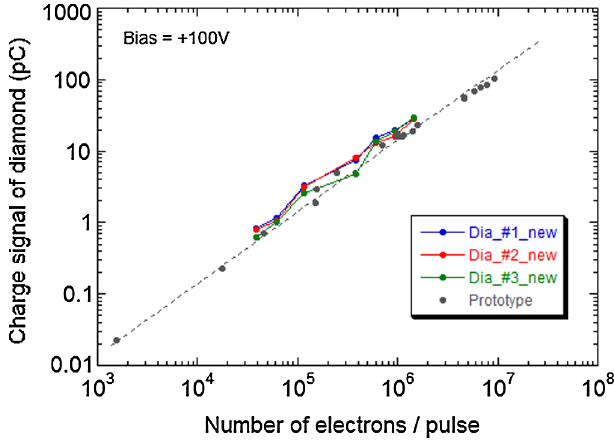
FIG. 15. Linearity of charge signal of the diamond-based detectors as a function of the number of incident electrons. Black dots indicate the results for the prototype diamond-based detector [7]. Typical pulse length of the incident electrons is 50 ps ( (cid:1)